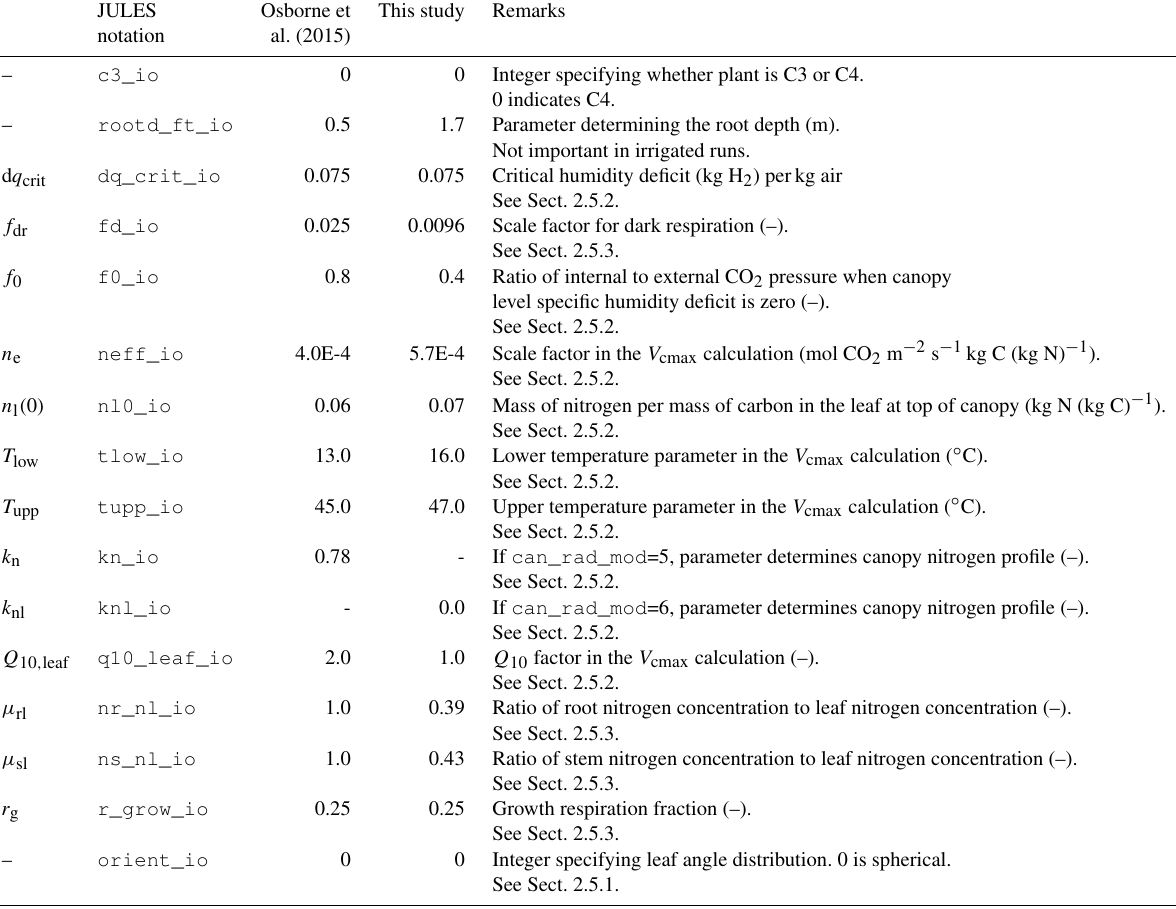
Table 2. JULES plant functional type parameters extended to represent maize. V cmax is the maximum rate of carboxylation of Rubisco. Units are given in brackets; (–) denotes dimensionless. These parameters are all specified in the JULES_PFTPARM namelist.